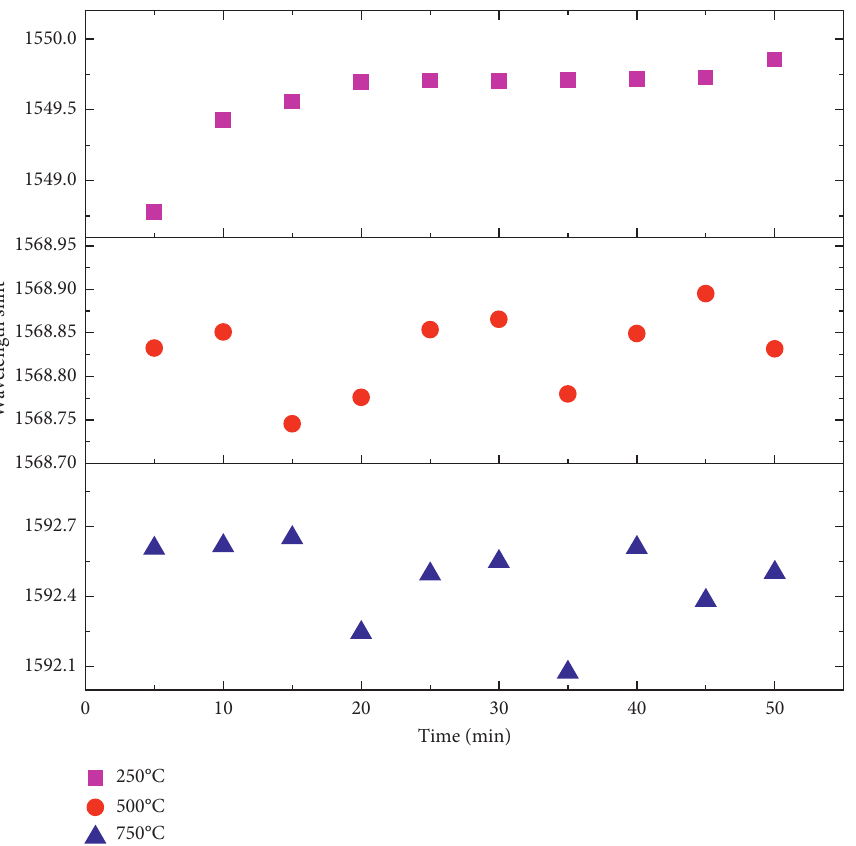
Figure 5: Signal changes with measurement time increasing at 250 ° C, 500 ° C, and 750 °